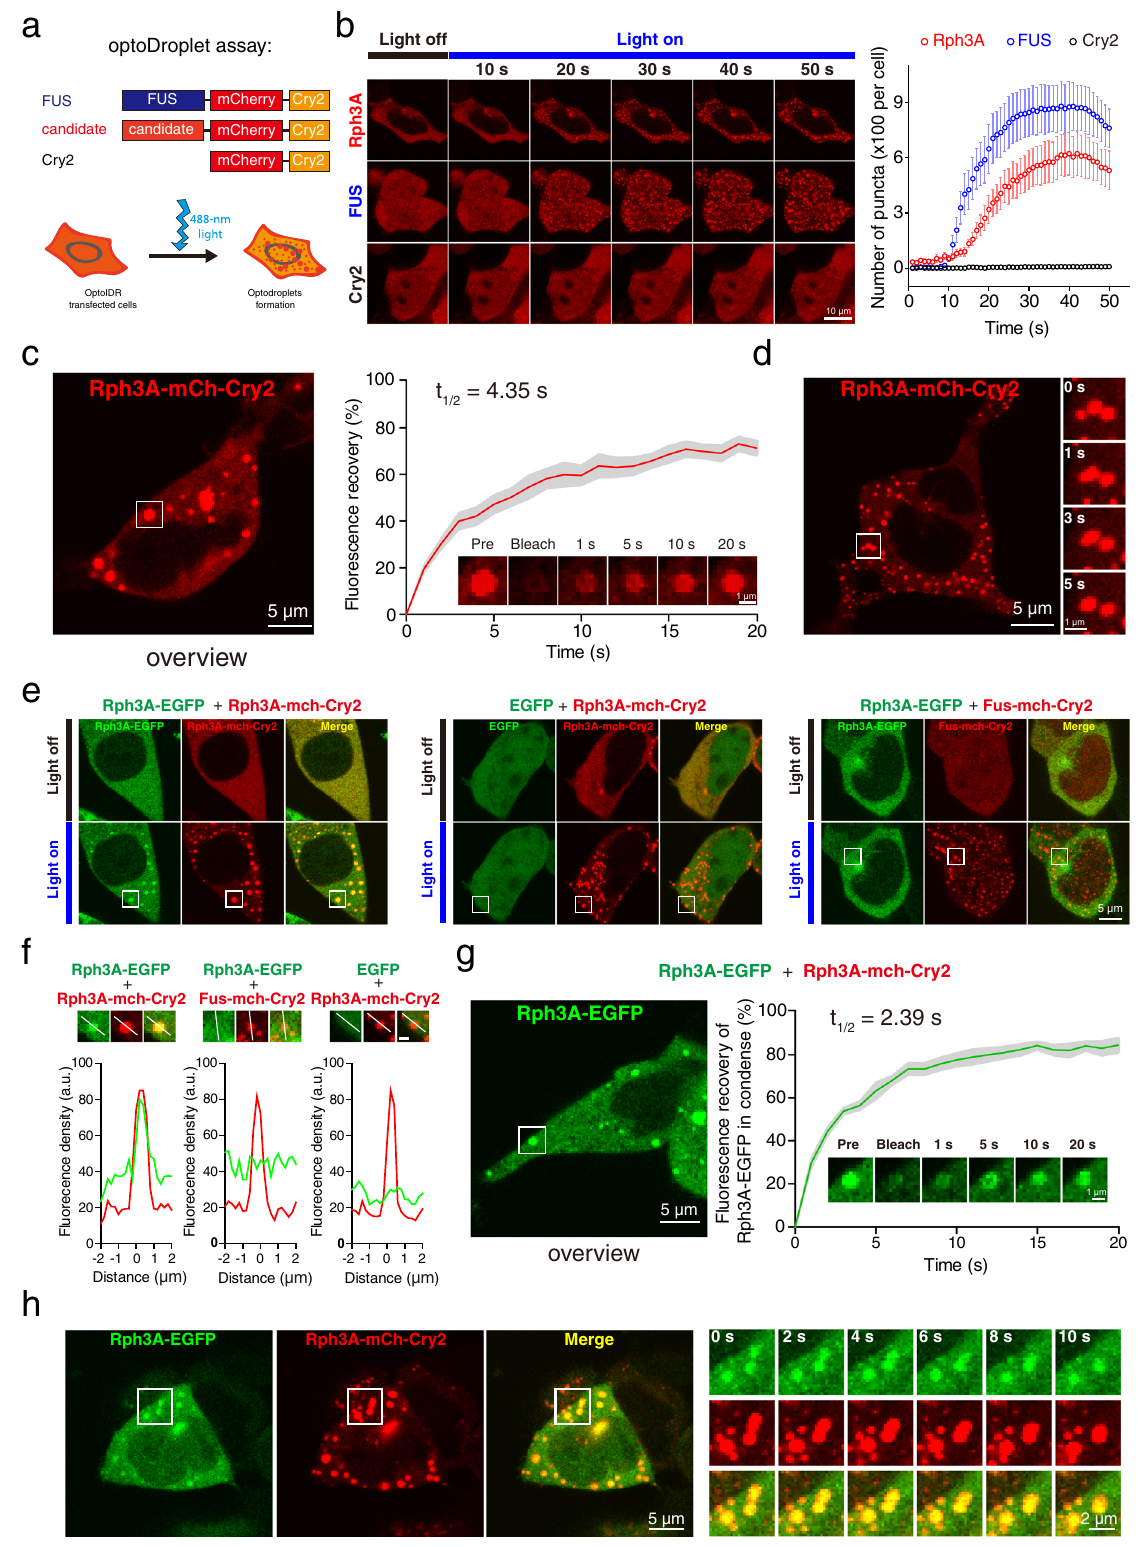
same concentration remained diffuse (Fig. 3a, middle and left). To test whether the Rph3A underwent phase separation without the presence of the crowding reagent, we concentrated the puri fi ed protein to 50 μ M in a buffer containing a physiological salt concentration (150mM NaCl) without a crowding reagent and we observed droplet formation (Fig. 3a, right). The size of the droplets formed by